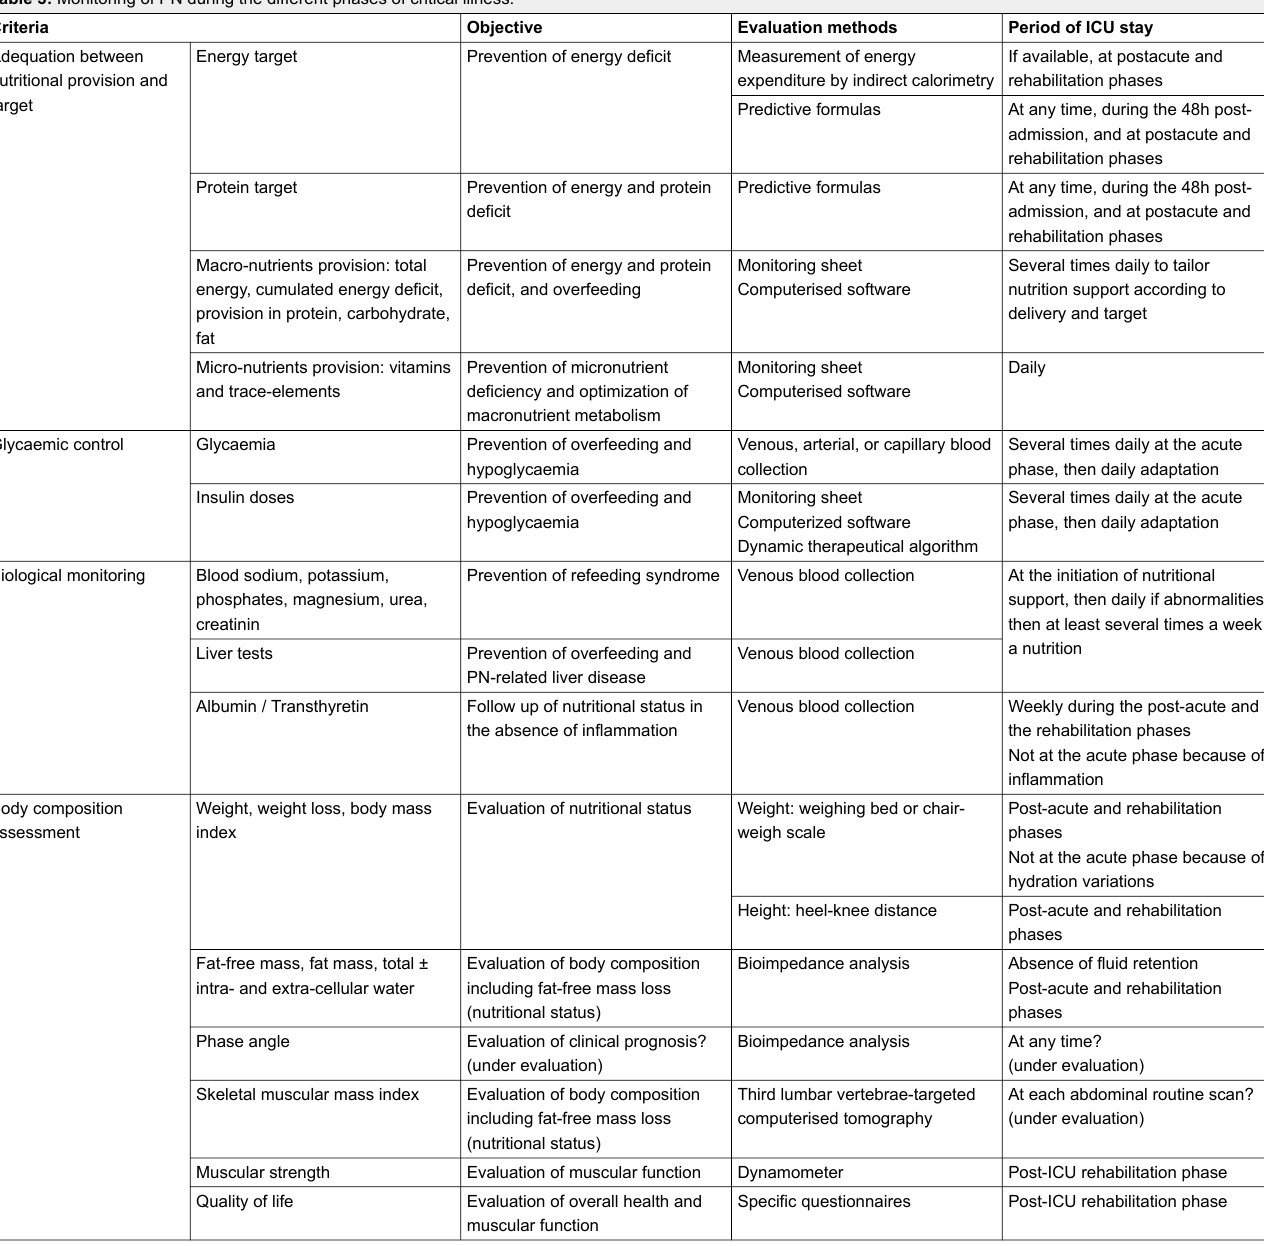
Table 3: Monitoring of PN during the different phases of critical illness.